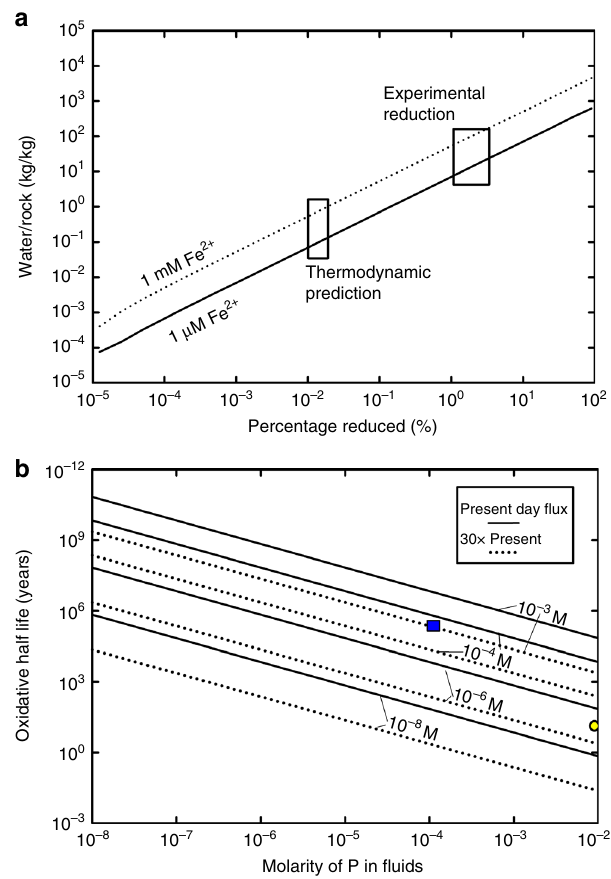
Fig. 3 Model results of the extraction of phosphite and its predicted steady- state abundance in an anoxic ocean. a Water-rock ratios required to completely extract phosphite from ferruginous sediments (0.3% P, Fe 2 + /Fe 3 + of 1/1). These calculations assume a total P content of 0.3% by weight, and that the P is in vivianite [Fe 3 (PO 4 ) 2 · 8H 2 O] or ferric phosphite — Fe 2 (HPO 3 ) 3 . Then, using the solubility data determined experimentally (ED), the quantity of water (pH 7.2) needed to completely dissolve phosphite was determined using the thermodynamic modeling program HSC Chemistry (Methods). Two scenarios were investigated: one where the water in contact with the rock had a starting Fe 2 + concentration of 10 − 6 M, and other, with a concentration of 10 − 3 M. The amount of phosphite predicted to form from thermodynamics and shown to form from experimental reduction, also imply that lower quantities of phosphite produced at low temperatures (<160 °C) will also be easily extracted at low water-rock ratios. b Steady-state concentration of phosphite predicted within the early oceans, as a function of molarity of phosphite dissolved from rock after diagenesis, oxidative half-life of phosphite for modern day hydrothermal fl uid fl uxes, and the higher values that might be expected in the Archean 28 . The blue square corresponds to the predicted phosphite fl ux from Fig. 3a, with the measured oxidative half-life of Fe(H 2 PO 3 ) 2 under low O 2 conditions (Methods). The yellow circle corresponds to the current measurements of half-life oxidation by biology 18 with the concentration of phosphite found within the ocean 15 , which implies a very high fl ux from sediments or hydrothermal sources, or more likely indicating that oceanic phosphite is not currently steady state, with respect to abiotic sources. This biotic oxidation rate is likely overestimated